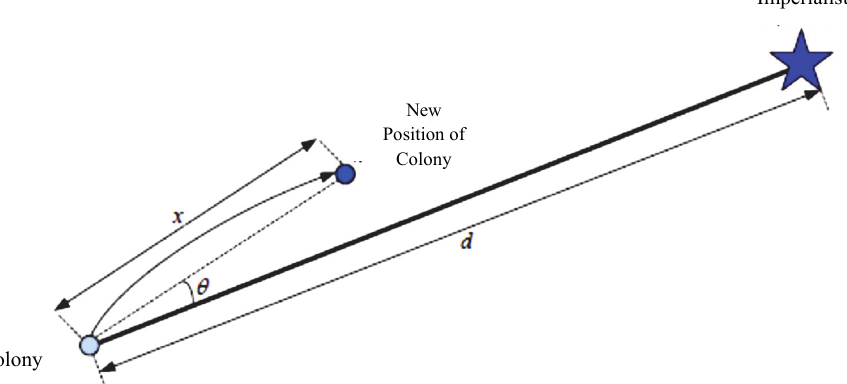
Fig. 2. The movement of colonies towards